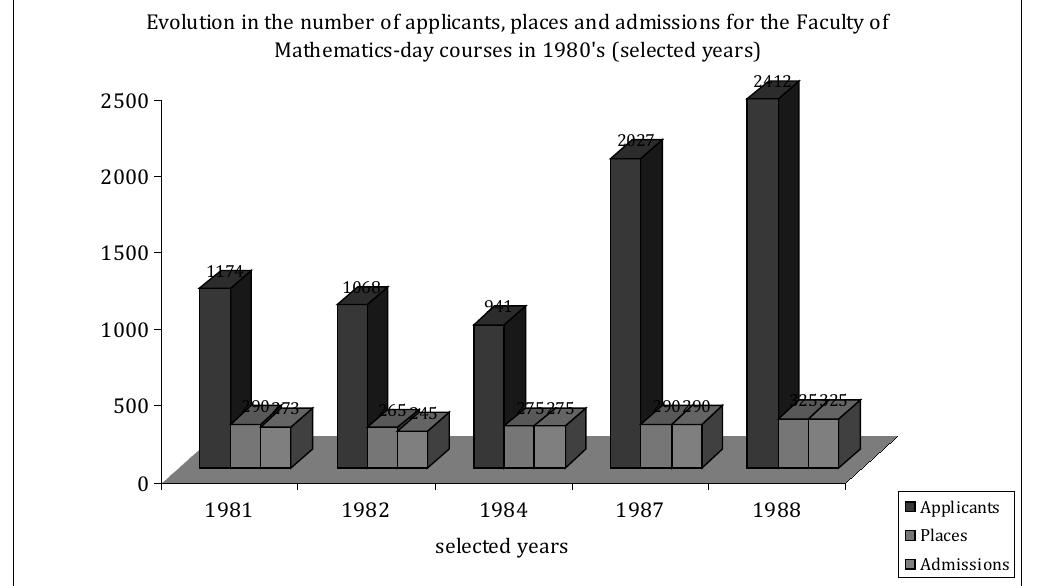
Figure 2. Evolution in the number of applicants, places and admissions for the Faculty of Mathematics – day courses in 1980’s (selected